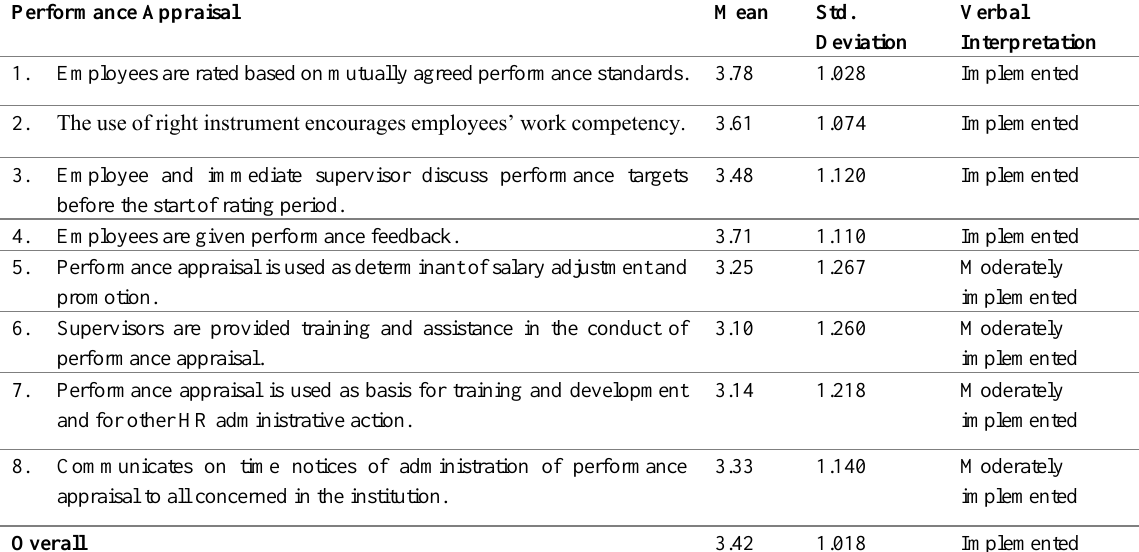
Performance Appraisal Mean Std. Verbal